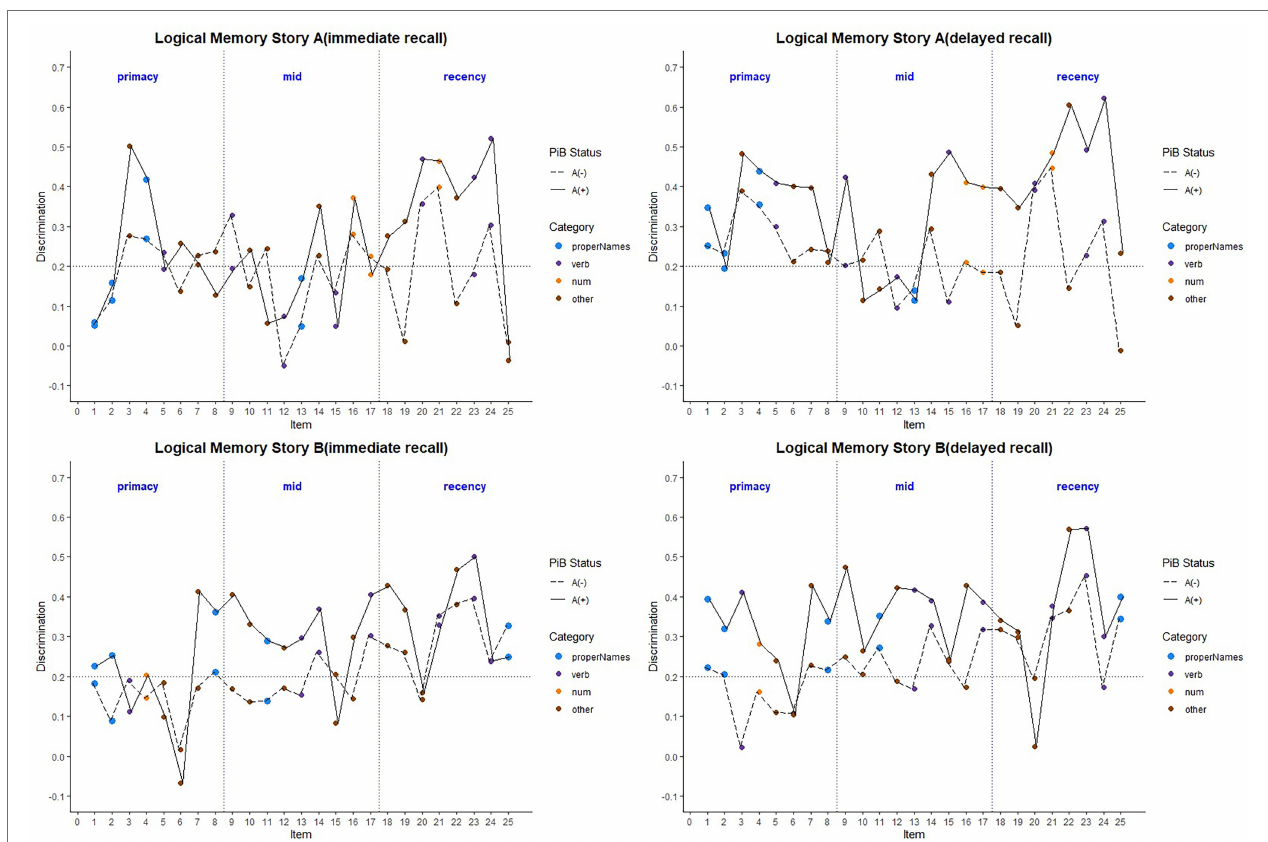
FIGURE 8 | Item discrimination plots according to the serial position (primacy, mid, and recency) as well as the lexical category of the items, by story A and story B. The colored circles indicate lexical categories, vertical dotted lines delineate serial position subgroups and line types are A β + and A β− group. The horizontal dashed lines are desirable discrimination values (>0.2). For immediate recall, the mean(SD) discrimination index was 0.540(0.22) for the A β + group compared with 0.594(0.23) in the A β− group ( w = 850.5; p = 0.0059; Cliff’s delta = − 0.32). For delayed recall, discrimination was 0.485(0.21) for the A β + group compared with 0.545(0.24) in the A β− group ( w = 530.5; p < 0.0001; Cliff’s delta = −